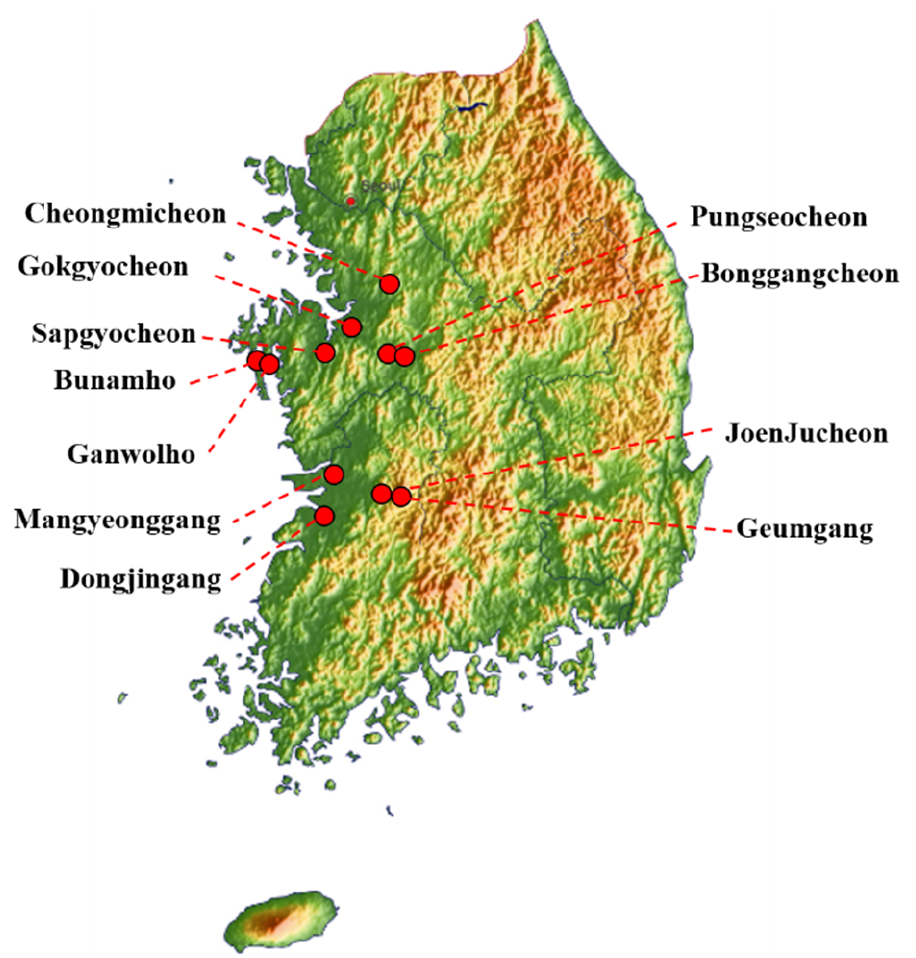
Figure 1. South Korean sampling sites.